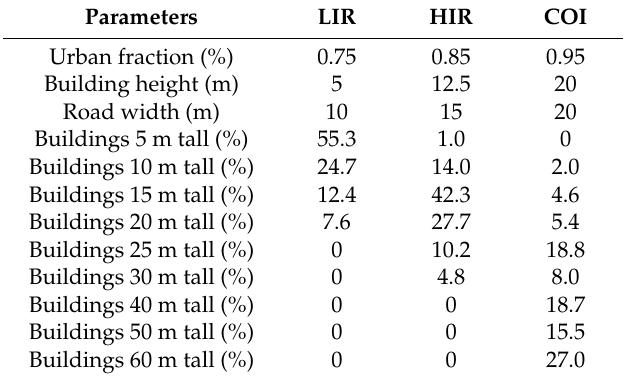
Table 1. Urban morphological parameters considered for the three urban classes: commercial or industrial (COI), high-intensity residential (HIR), and low-intensity residential (LIR).